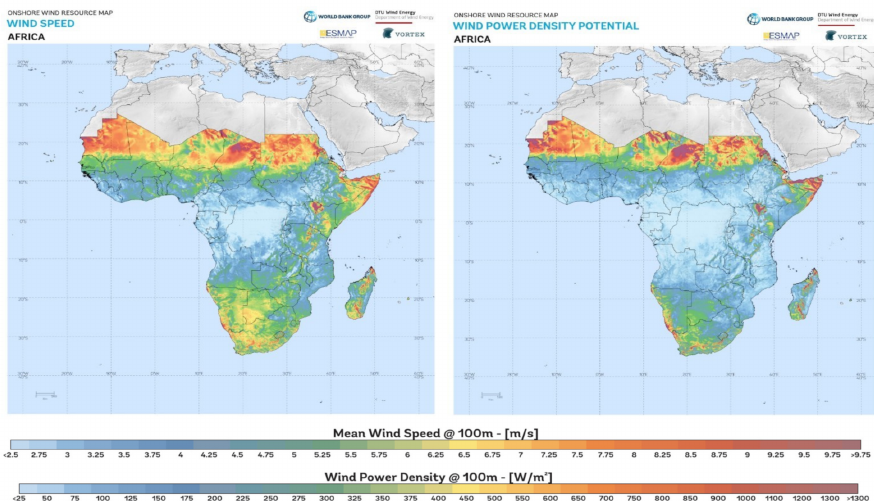
Figure 1. ( left ) Wind speed distribution in SSA; ( right ) Wind power density distribution in SSA [21].